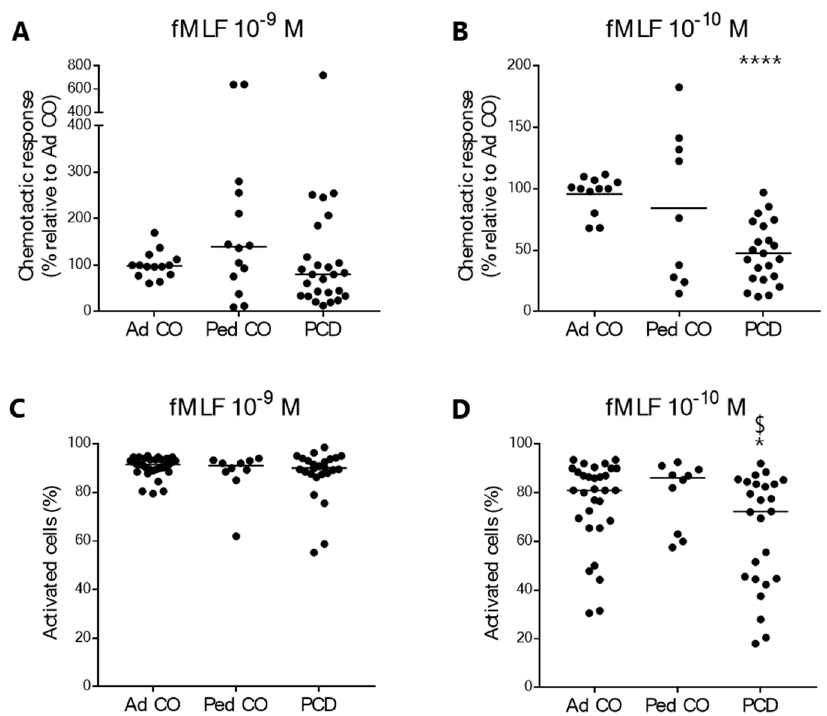
Figure 1. Peripheral blood PMNs from patients with PCD show reduced chemotactic response to low concentrations of fMLF. Chemotactic responses of neutrophils (PMNs) from patients with PCD (PCD, n = 22–26 [18–20 pediatric and 4–6 adult]), age-matched healthy pediatric controls (Ped CO, n = 9–14) and healthy adult controls (Ad CO, n = 12–31) in ( A , B ) the Boyden chamber chemotaxis assay and ( C , D ) the shape change assay. The chemotactic response to two different concentrations of fMLF was assessed: ( A , C ) 10 − 9 M and ( B , D ) 10 − 10 M. The chemotactic index (CI; average number of migrated cells in response to the chemoattractant divided by the average number of spontaneously migrated cells) was used to express the chemotactic response. The CIs were normalized to the CI of the corresponding reference Ad CO (%). Statistical differences were determined by Mann-Whitney U-test (Ad CO versus PCD: * p < 0.05, **** p < 0.0001; Ped CO versus PCD: $ p < 0.05).